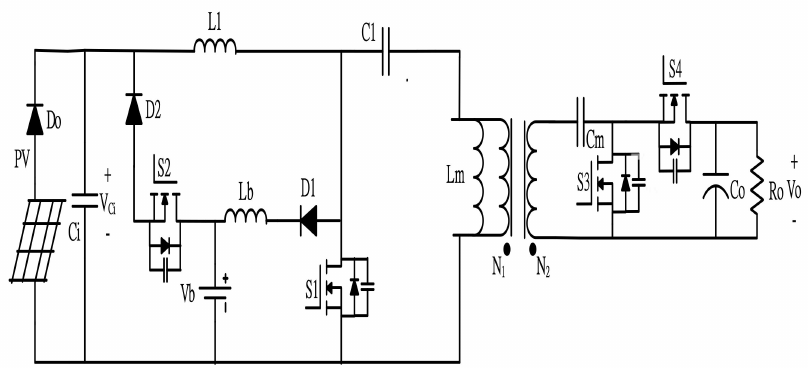
Figure 3. Novel isolated three-port bidirectional DC/DC converter.